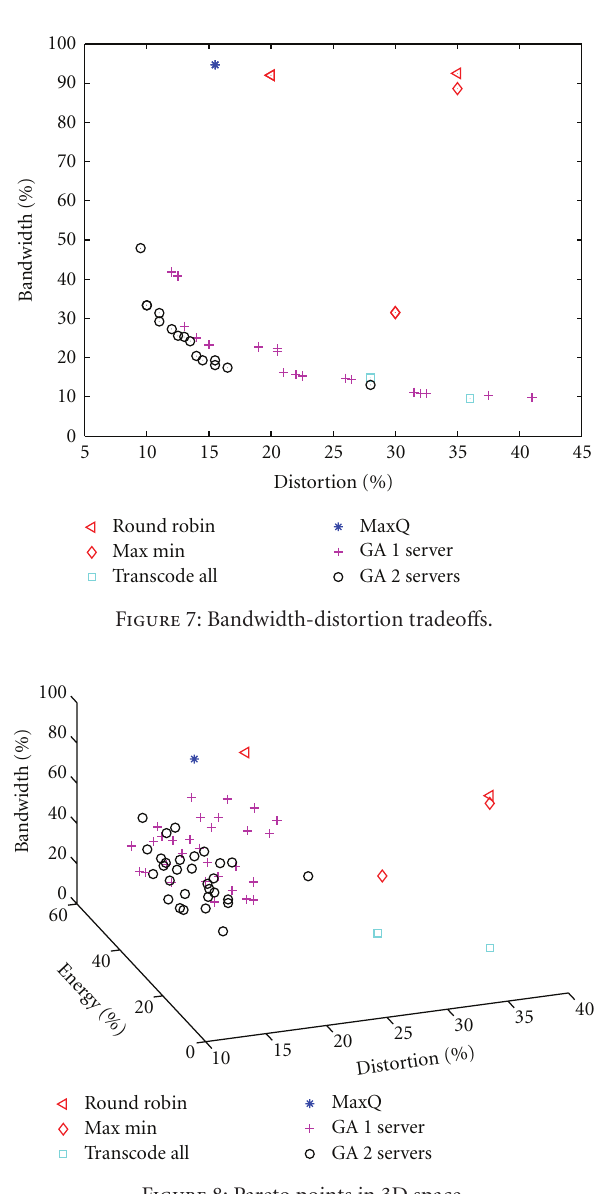
Figure 8: Pareto points in 3D space.